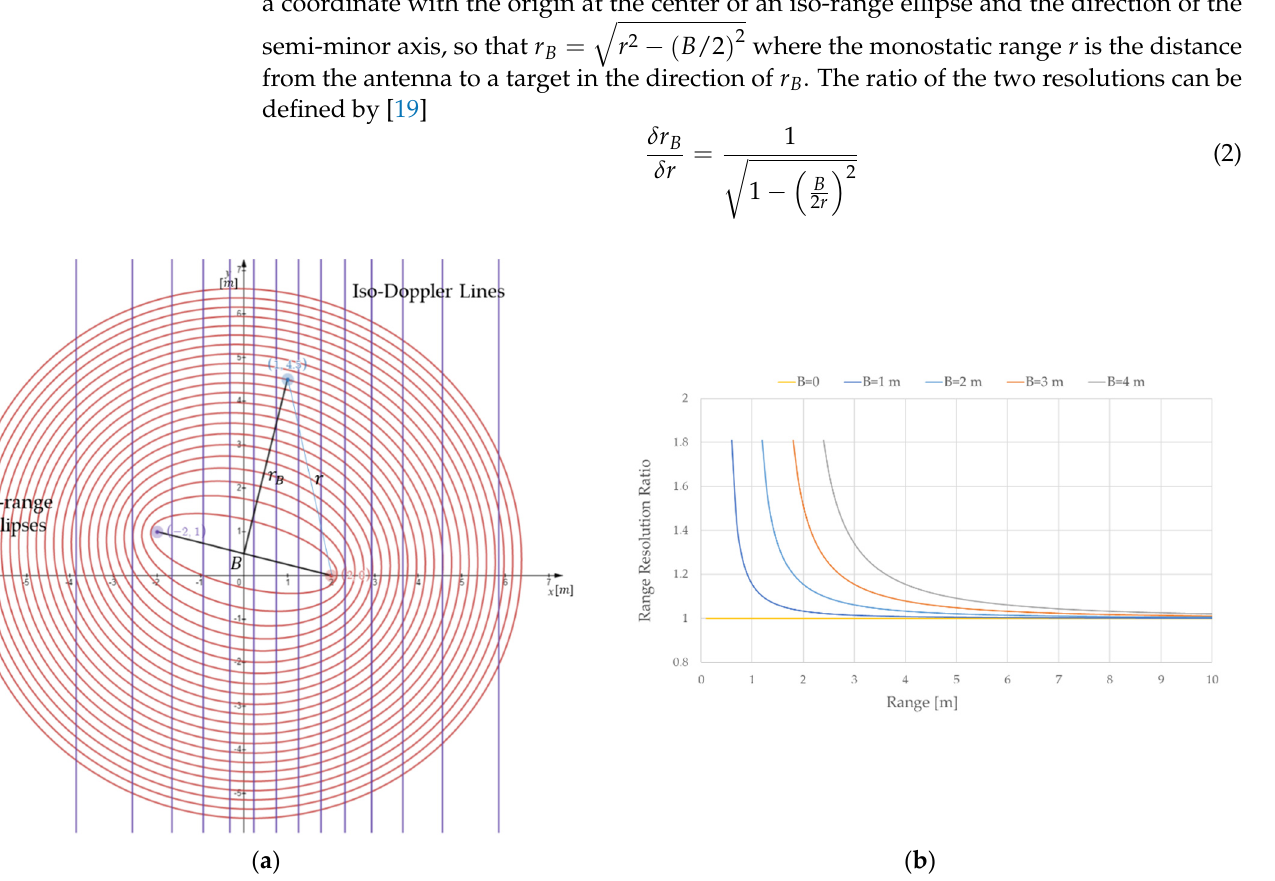
Figure 2. Bistatic SAR geometry with one stationary and one moving antennae. ( a ) Iso-range ellipses with two antennae separated by B, and iso-Doppler lines for a target at (1, 4.5). ( b ) the ratios of range resolution for a bistatic radar over a monostatic radar ( δ r B / δ r ) with different